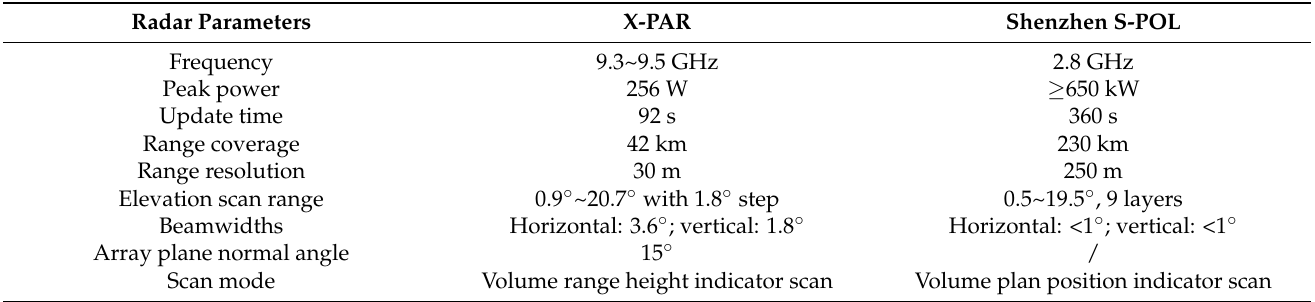
Table 1. X-PAR and S-POL radar